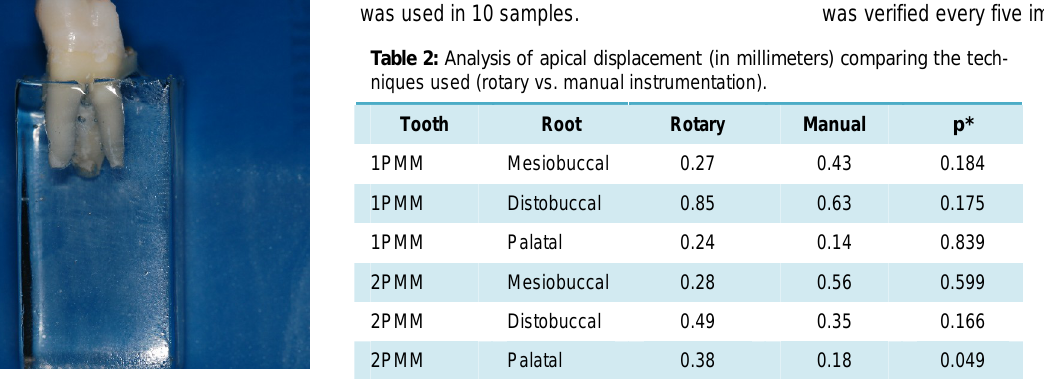
Figure 1: Tooth embedded in clear acrylic-resin block.